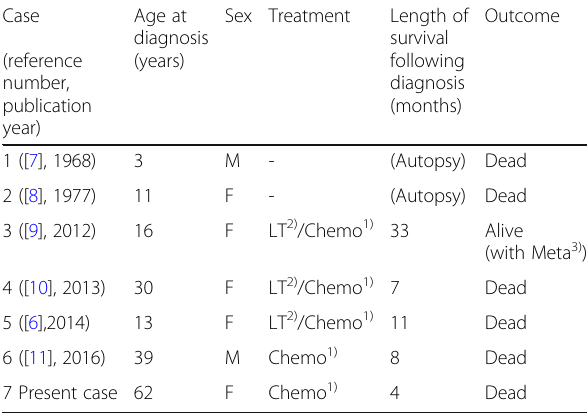
Table 2 Cholangiocarcinoma in biliary atresia